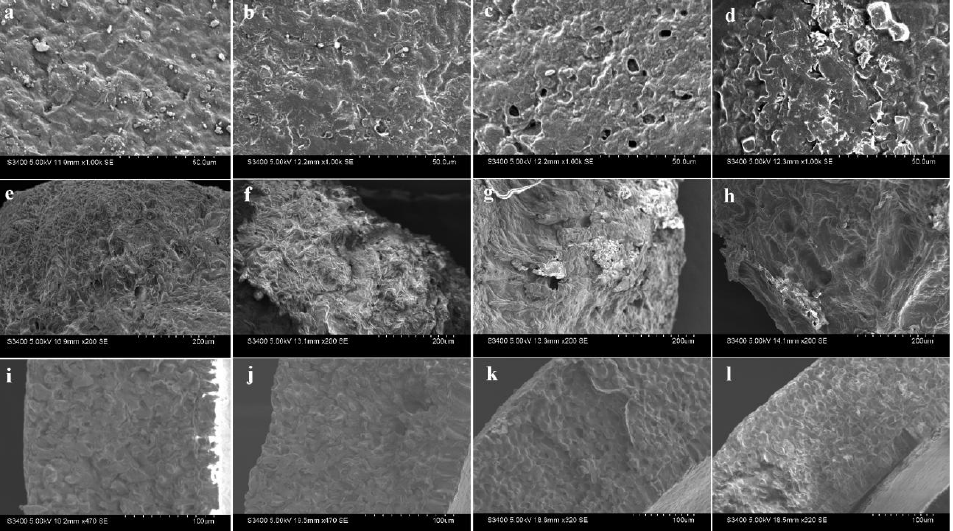
Figure 5. Exotesta of intact dry (DS), imbibed (BS), cracked (CS), and germinated (GS) seeds of Chinese pistache ( a – d ); hilum of DS, BS, CS, and GS ( e – h ); and exotesta section of DS, BS, CS, and GS ( i – l ) under a scanning electron microscope.